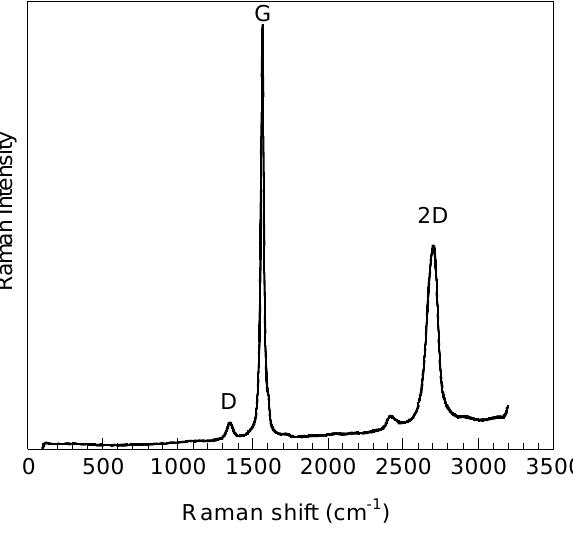
Figure 2. Raman spectrum of GO sigma .